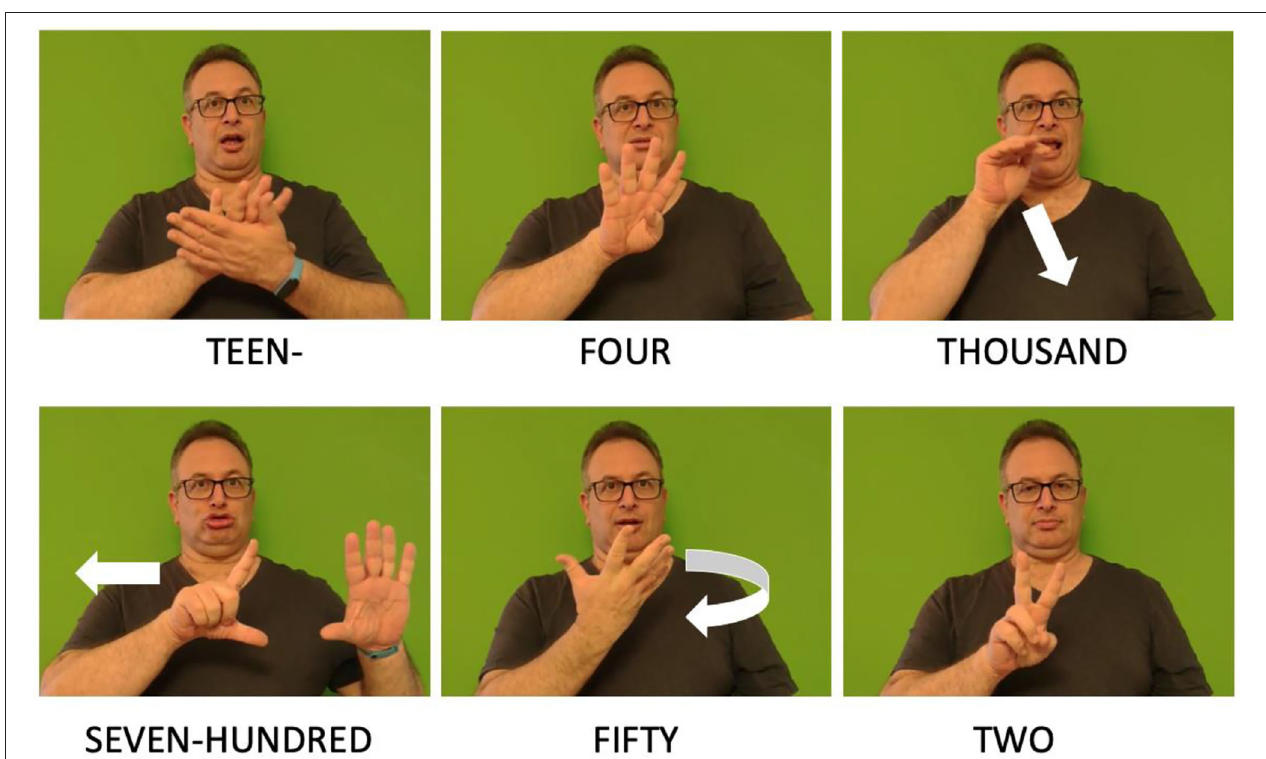
FIGURE 4 | The multidigit number 14752 in ISL (To see the videos, click the pictures).